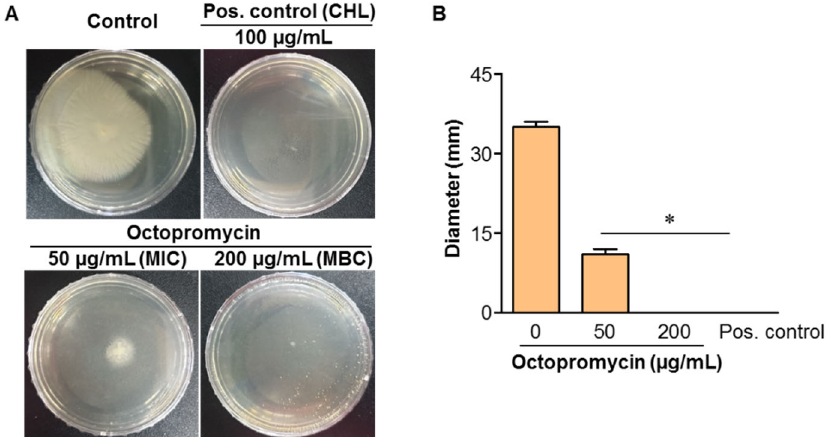
Figure 5. Effect of octopromycin on twitching motility of A. baumannii . Single colony of A. baumannii was picked from a TSA culture plate, inoculated vertically to the bottom of the plate, and images were taken after 20 h of incubation at 25 °C. ( A ) Twitching motility of A. baumannii in the presence of octopromycin MIC (50 μ g/mL) and MBC (200 μ g/mL). ( B ) Diameter of the twitch motility of A. baumannii . Positive (Pos.) control; CHL (100 μ g/mL) used as a * p ≤ 0.05 compared to the untreated control. The error bars indicate mean ± standard deviation ( n = 3).